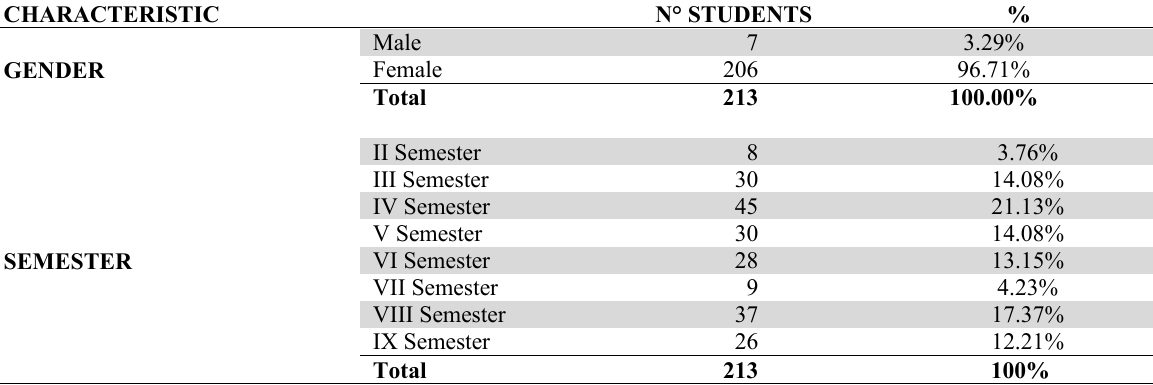
Distribution of FATS - UNCP students by